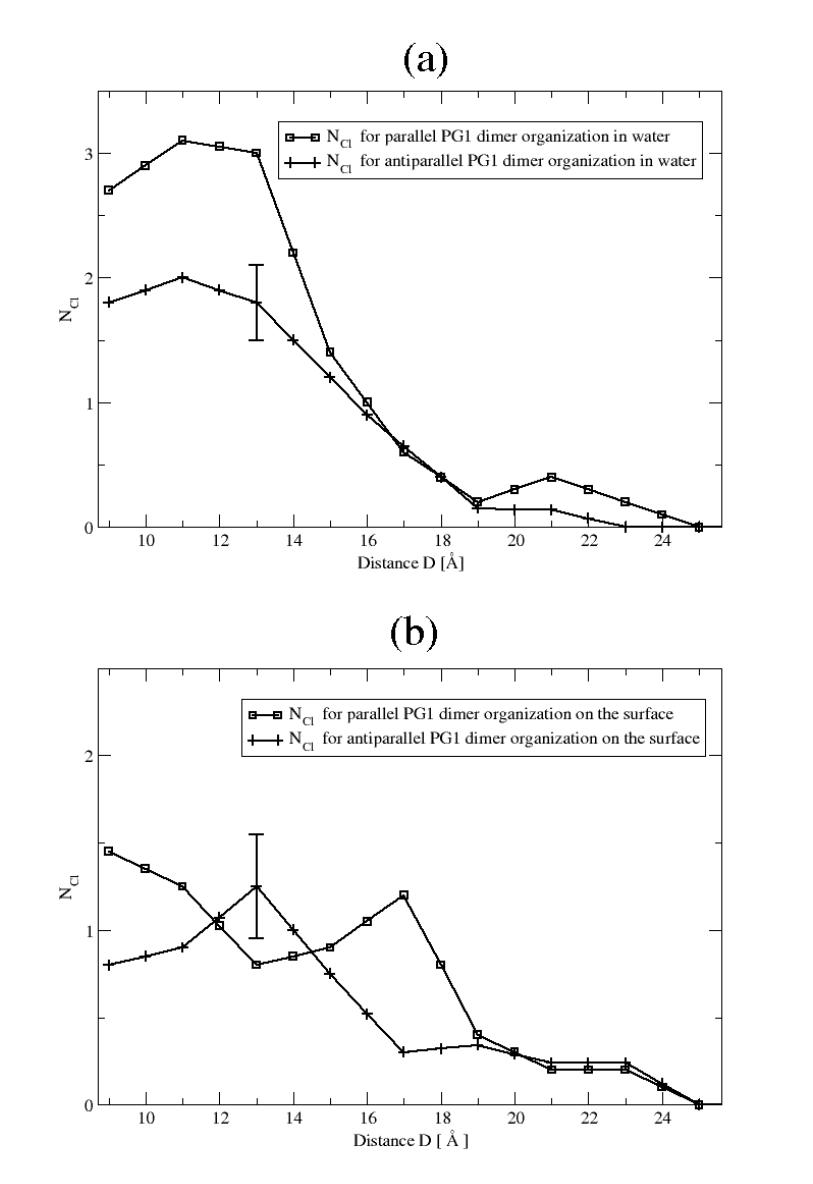
Figure 4. Average number, N of chloride counterions bound to PG1 peptides as a function Cl of the distance D, between the two peptides, for the parallel and the antiparallel β -sheet arrangement (a) in water and (b) on the surface of the POPE/POPG membrane.